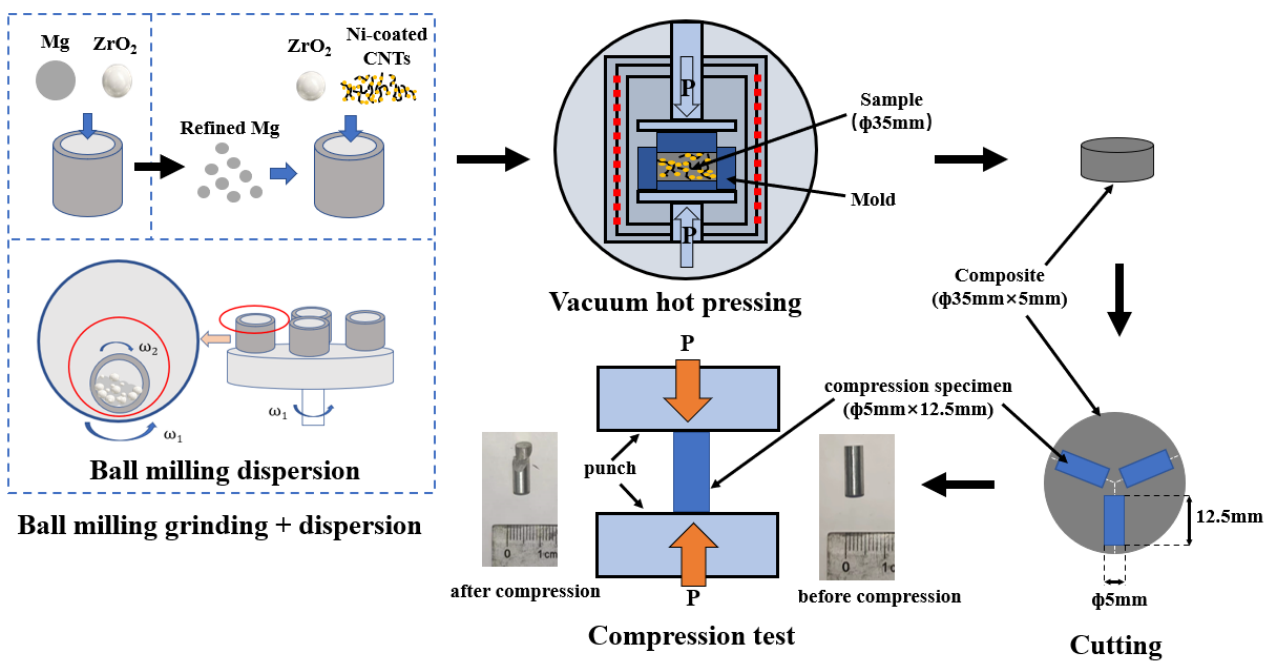
Figure 1. Preparation flow chart of the CNT/Mg composites.